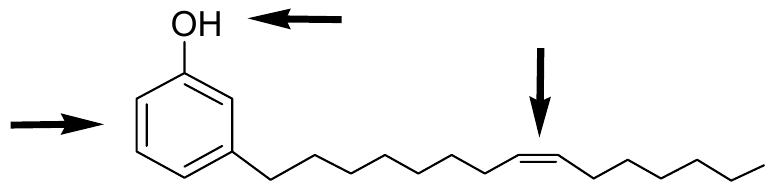
Figure 2. Possible sites for functionalization of the cardanol